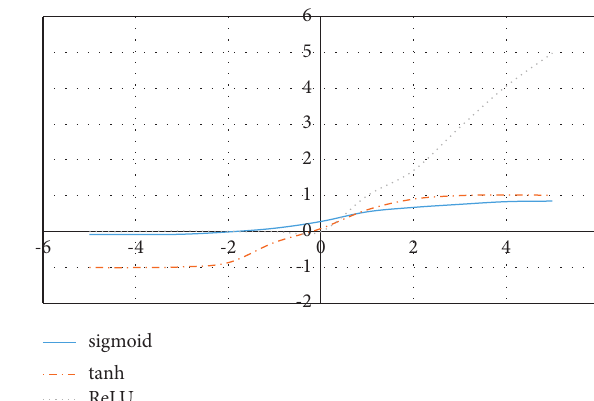
Figure 4: Curves of sigmoid, tanh, and ReLU activation functions.